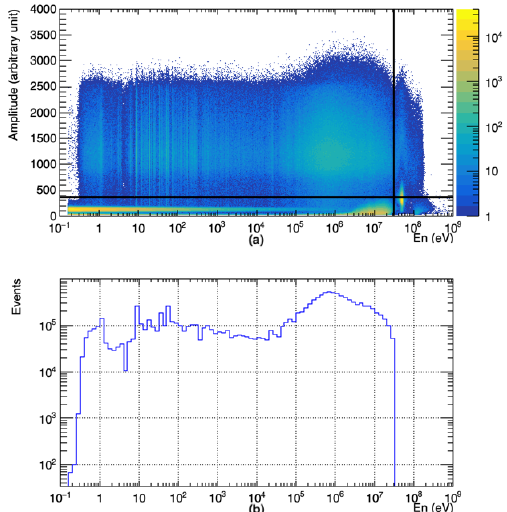
Figure 1: Layout of the Back-n beam line at CSNS.